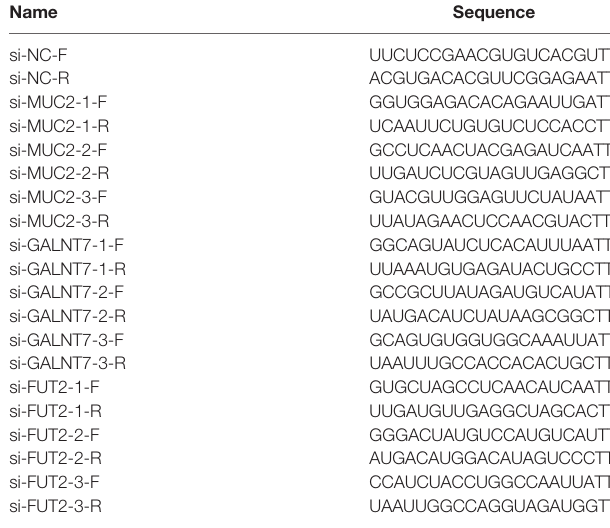
TABLE 2 | siRNA sequences used in this